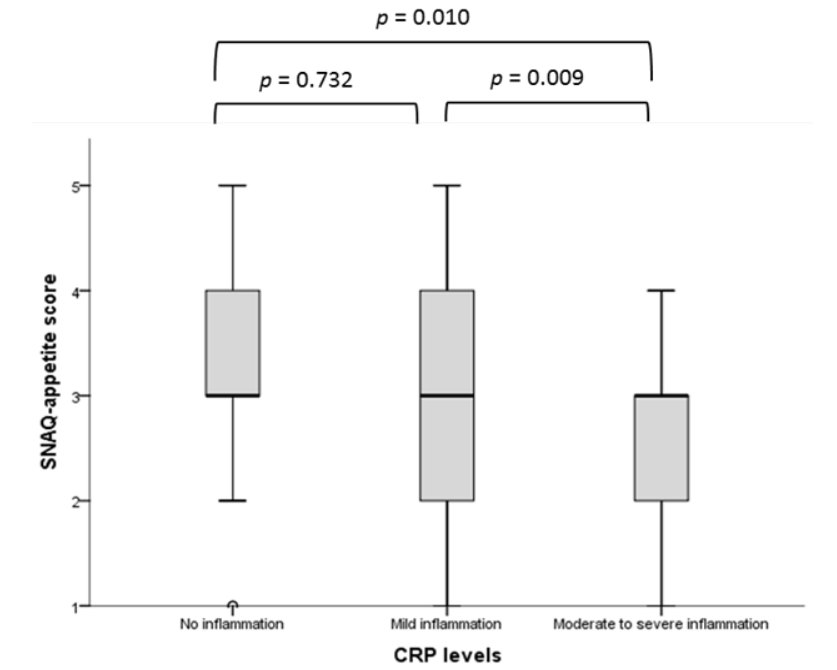
Figure 1. Comparison of SNAQ-appetite score across the CRP levels in total population ( n = 200). SNAQ, Simplified Nutritional Appetite Questionnaire; CRP, C-reactive protein.